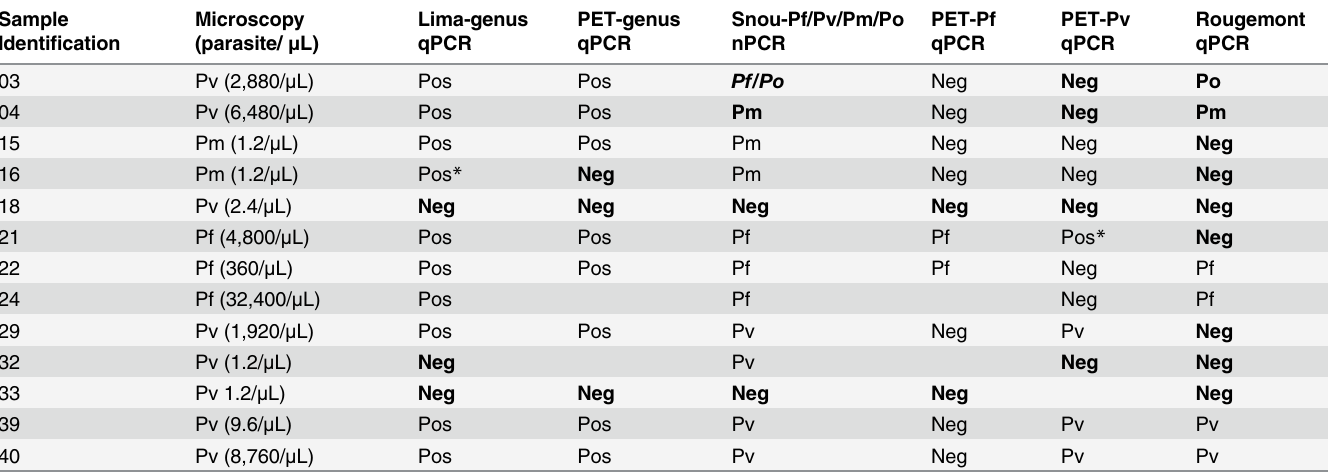
Table 2. Comparison of molecular assays to microscopy in individual samples. Sample Identi fi